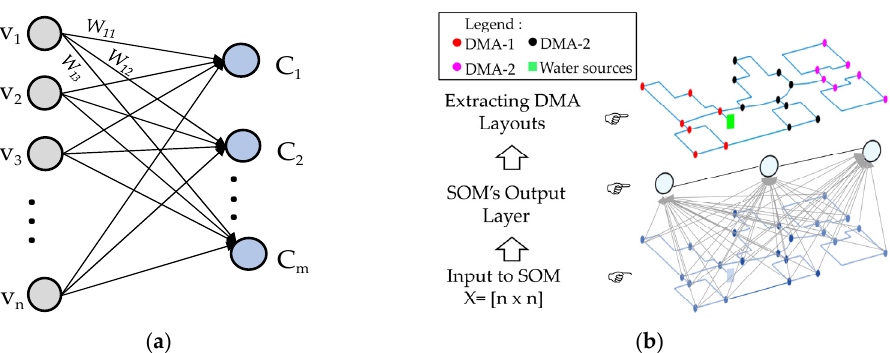
Figure 2. Illustration of self-organizing map (SOM) model: ( a ) two-layer SOM for community detection; ( b ) schematic to illustrate the performance of SOM to determine district metered areas (DMAs) in water distribution network (WDN).